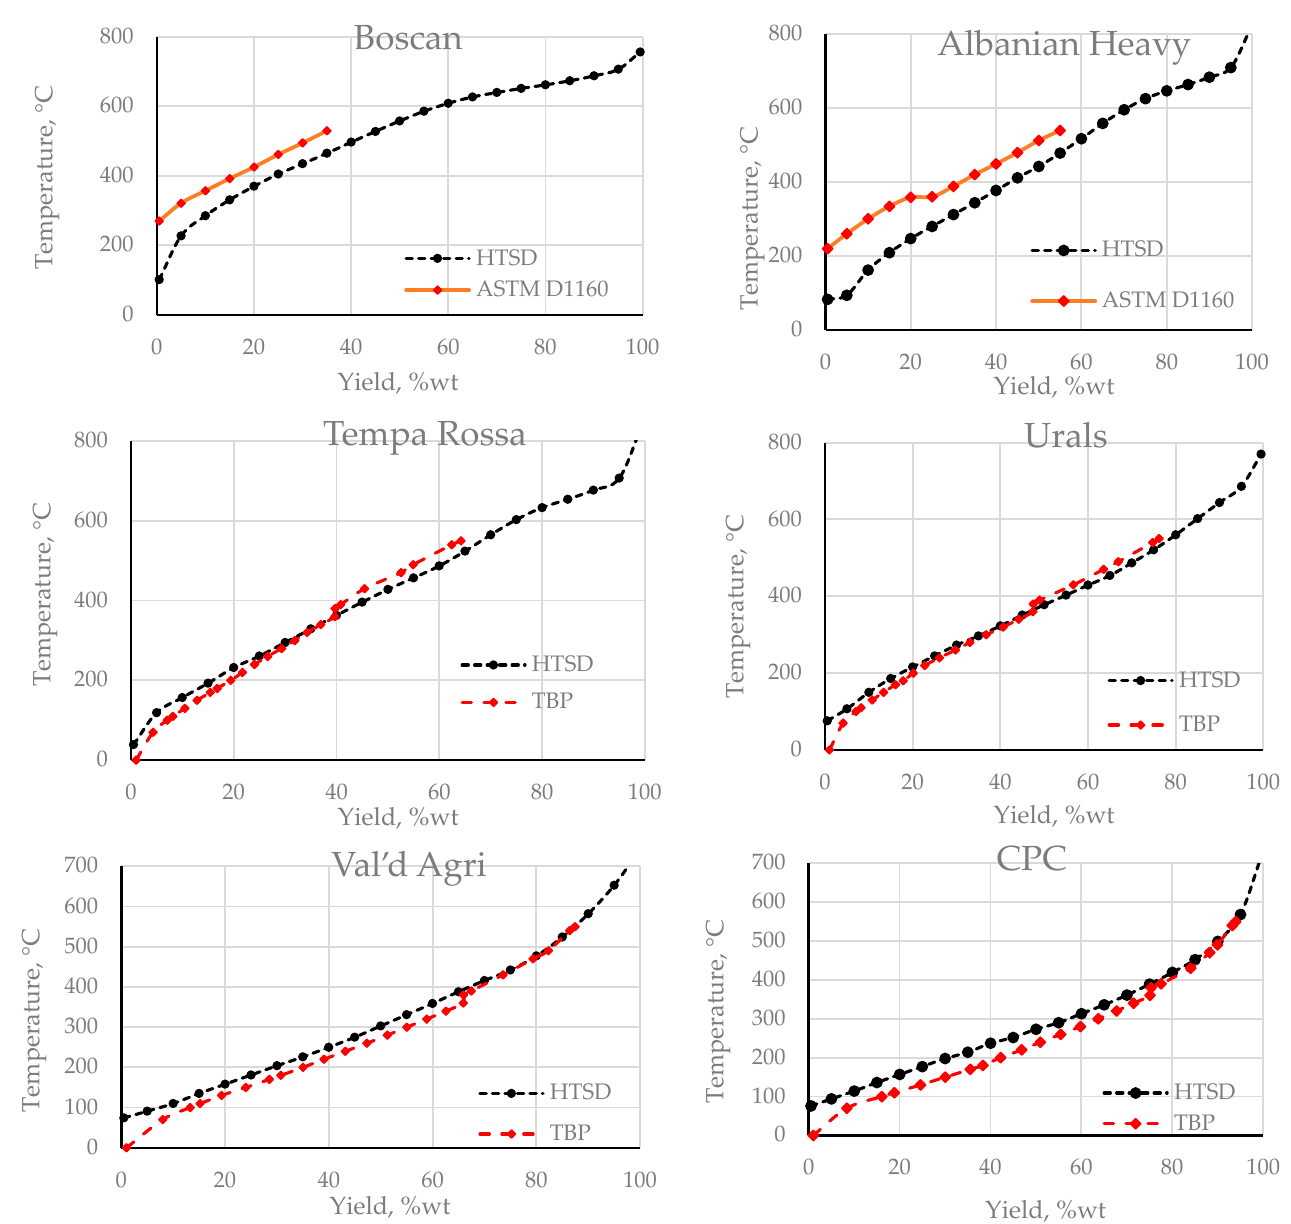
Figure 6. HTSD and TBP distillation curves of heavy-extra heavy (Boscan, Albanian), heavy (Tempa Rossa), medium (Urals), light (Vald’Agri), and extra light (CPC).